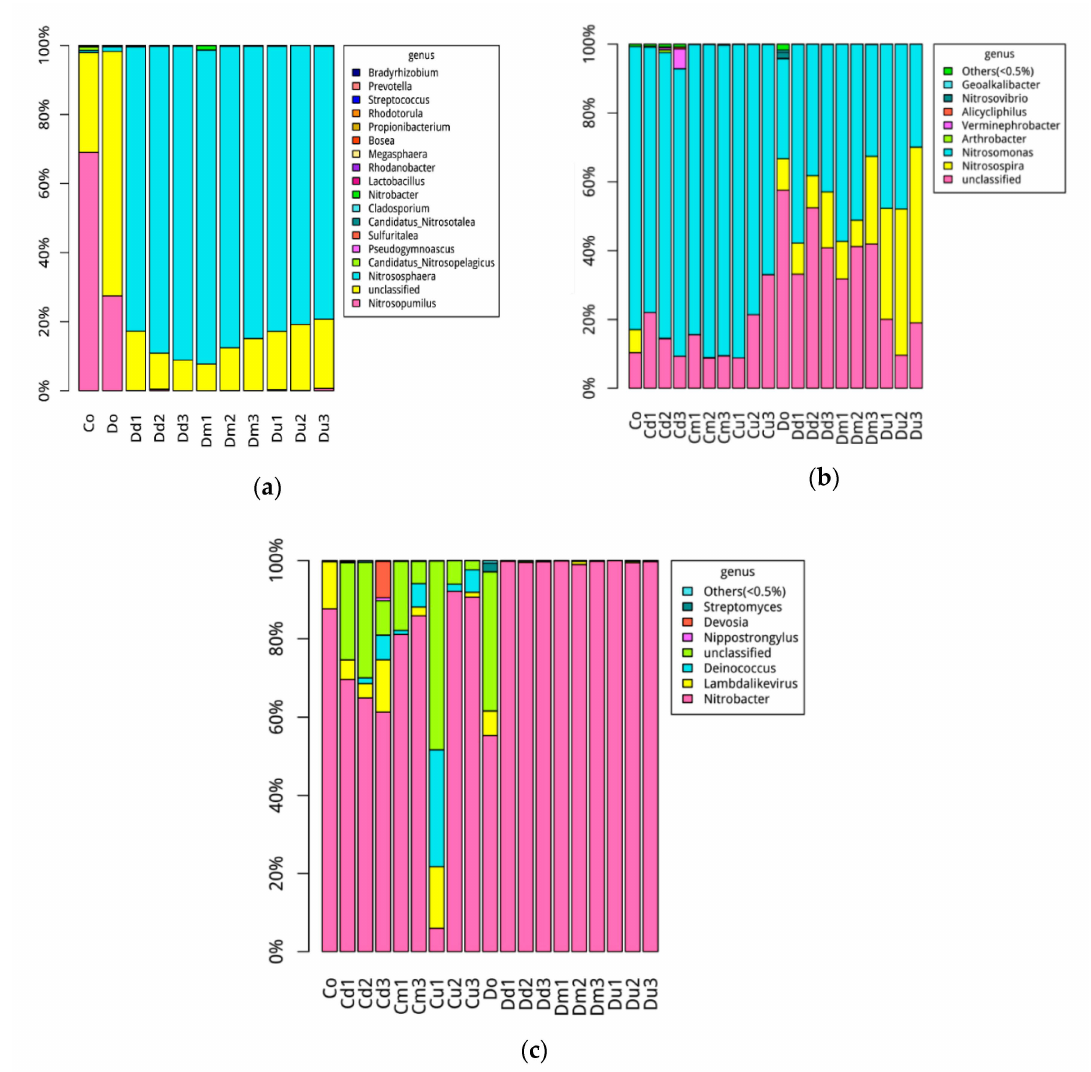
Figure 5. Microbial community composition of ( a ) AOA, ( b ) AOB, and ( c ) NOB at genus-level from di ff erent heights and times in